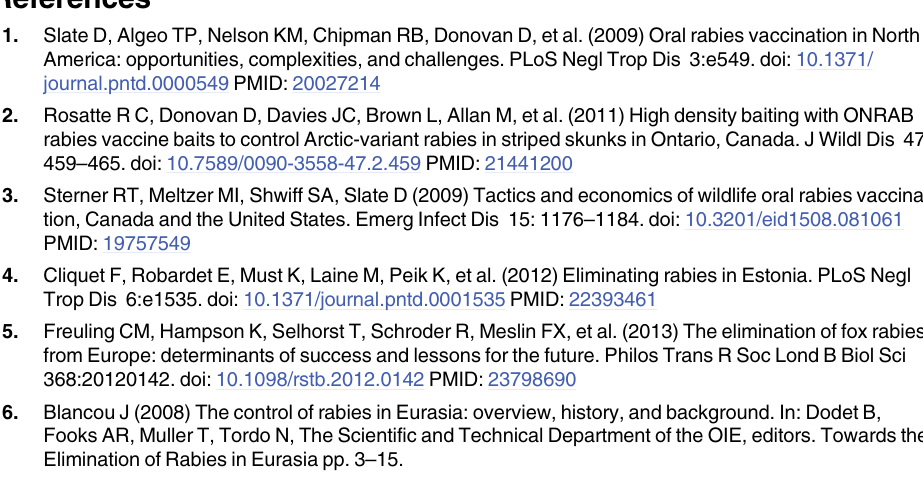
S1 Table. Position coordinates (UTM zone 16) for capture locations of all raccoons that tested positive for Rhodamine B uptake. S2 Table. Post bait sampling results. The sex (M = male, F = female), age (A = adult, J = juve- nile, Y = yearling, see text for details), site (C = control, T = treatment), and Rhodamine B up- take (0 = negative, 1 = positive) for all raccoons and Virginia opossums captured during post bait